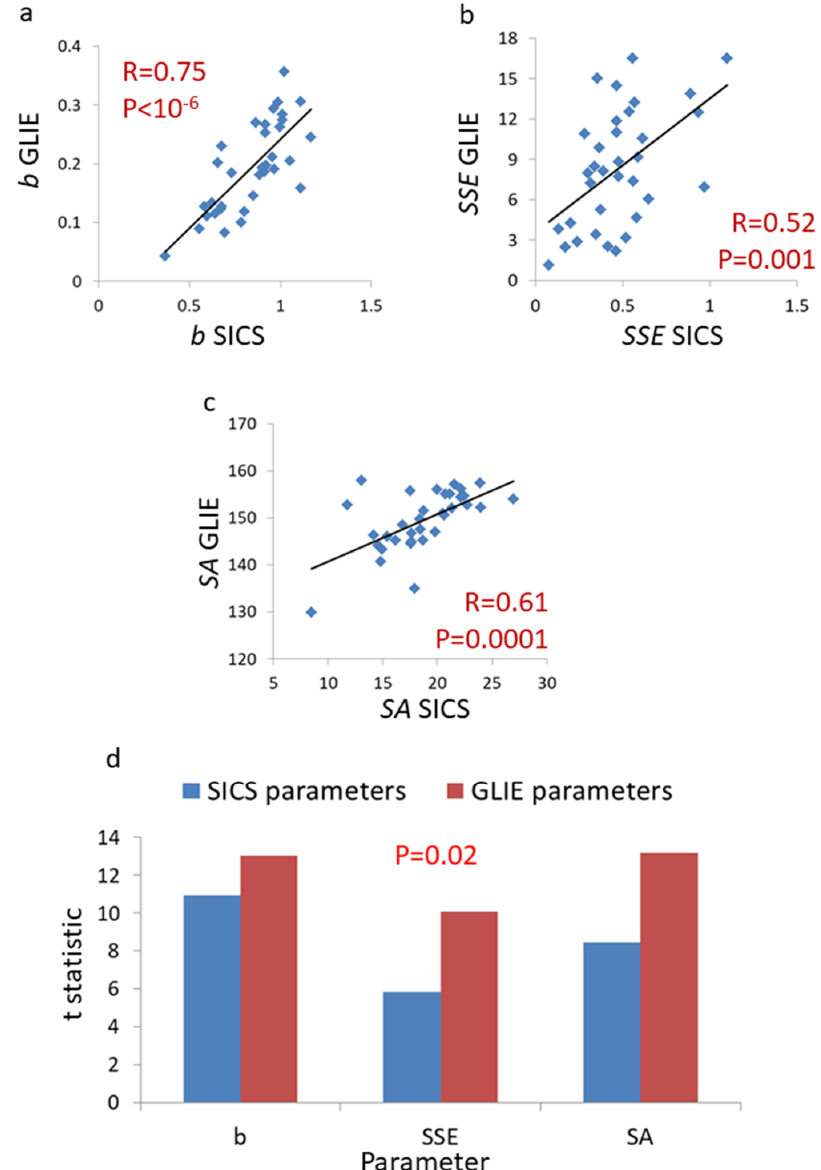
Figure 7. Correlation between the power fit and ASD parameters calculated by SICS analysis and the corresponding parameters that were calculated by GLIE analysis in active Jurkat cell (n = 34). The correlation between b parameter results ( a ) or Sum of Squared estimate of Errors (SSE) parameter results ( b ) or Sum of Amplitudes (SA) parameter results ( c ) following SICS analysis and the same parameters results following GLIE analysis in the Jurkat cells. ( d ) A comparison of t-statistic values for the difference in results in cells before and after ATP depletion that were obtained for each parameter and each method of analysis (SICS vs. GLIE analysis). Corresponding parameters (such as b of SICS analysis versus b of GLIE analysis) are compared and the p -value for the significance of the difference in t-statistic results between the two methods of analysis is also presented ( p = 0.02). In panels a – c the R-values of each correlation and p -values for the significance of that correlation are presented.